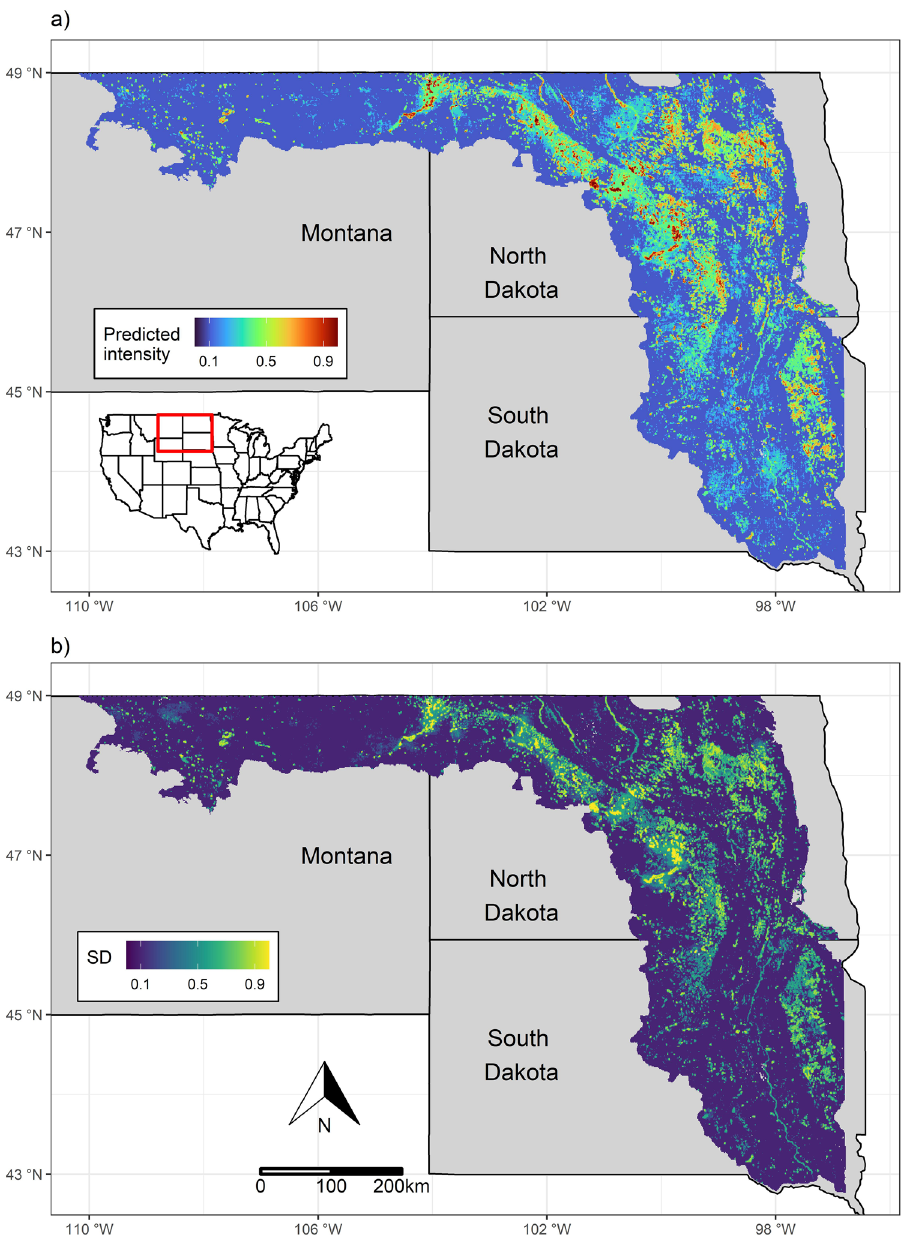
Figure 2. Average ( a ) and standard deviation ( b ) of predicted piping plover ( Charadrius melodus ) breeding habitat use and density across our nest data collection period (2000–2019). To allow for improved visualization, maps were aggregated to 900 m resolution using the mean of pixel values and normalized by rescaling values between 0 and 1. Maps were generated using R (version 4.1.3) 55